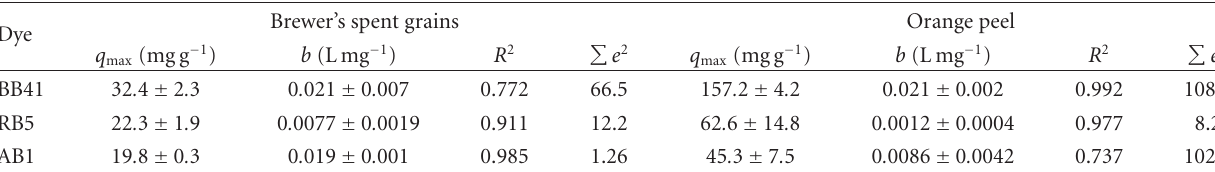
Table 3: Langmuir model parameters.